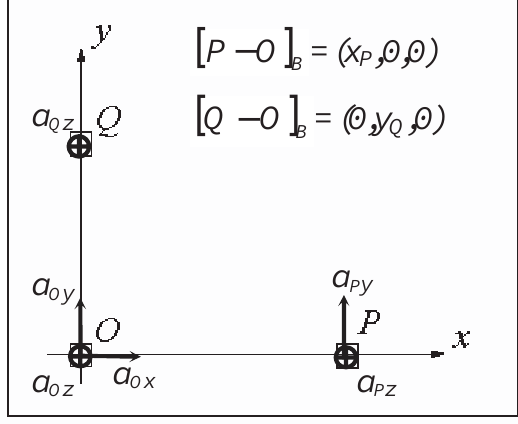
Fig. 1. Placement of the